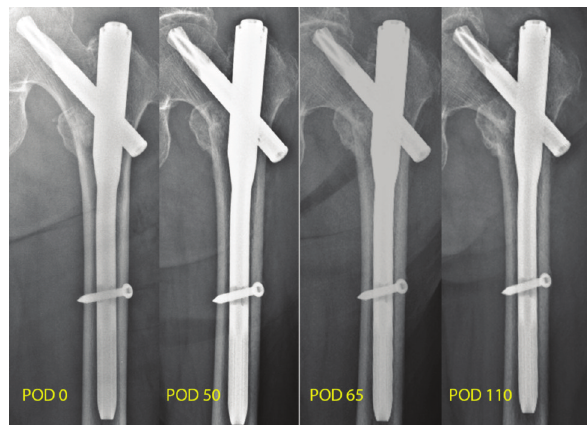
Serial radiographs showing progressive superior cutout Fig. 11: of the FNE, varus collapse of the proximal fracture fragment, femoral head perforation and subsequent acetabulum penetration in the group without medial migration.